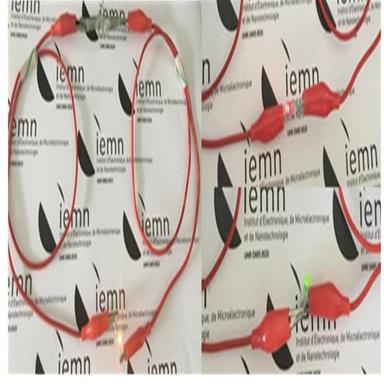
Photographs of LEDs (yellow, red and green) powered by two asymmetric supercapacitors connected in series. (For interpretation of the references to colour in this figure legend, the reader is referred to the Web version of this article.)